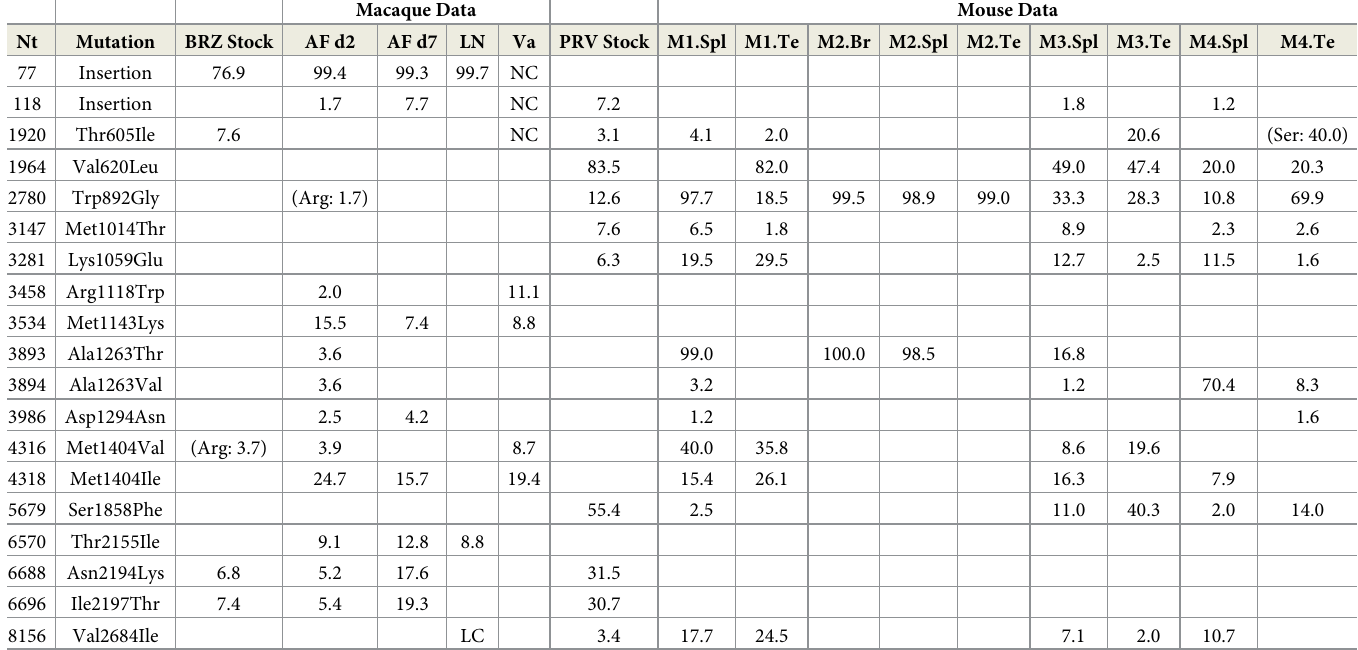
Table 5. Nonsynonymous variants detected in two or more samples during in vivo passage. Mutation frequencies (shown as percent) with a frequency of > 1% were identified using CLC Workbench. Sample sequences were compared to the Genbank sequence for each strain to identify variant sites. Low frequency mutations were veri- fied using overlapping read pairs (ORP) and error modeling [40]. Sites with 2 different variants present have the second variant amino acid noted next to the frequency (i.e. Thr605Ser detected for sample M4.Te at 40%). NC = no coverage at this site; LC = Low coverage (less than 300 reads). Frequencies were derived by alignment of reads to the appropriate reference sequence from GenBank. Mice are numbered 1–4. AF amniotic fluid, LN lymph node, Va vagina, Spl spleen, Te testes. Br Brain, d day post